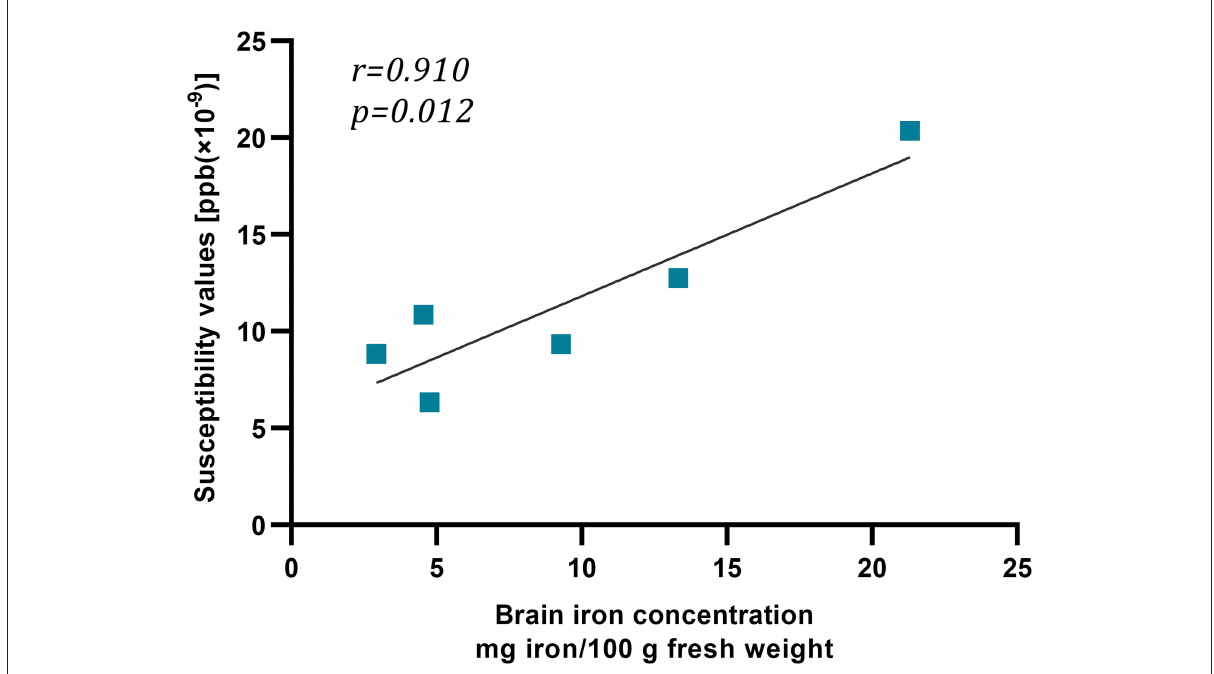
FIGURE3 The relation between susceptibility values and iron concentration. This graph showed strong linear relation between susceptibility values [ppb ( × 10 − 9 )] and iron concentration (mg iron/100g fresh